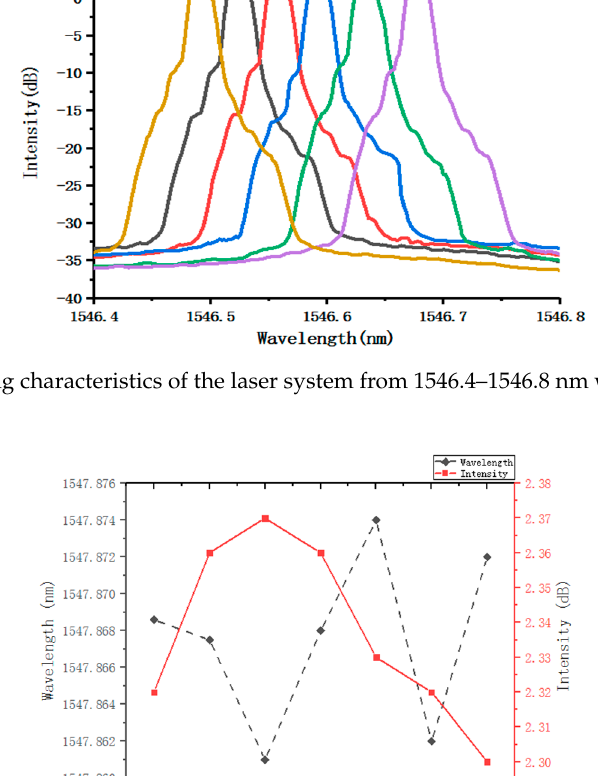
6 of 8 Figure 5. Typical laser signal with the wavelength centered at 1546.733 nm. Different holograms are loaded onto the DMD chip, each hologram corresponds to a different selected wavelength. Each selected wavelength is amplified by EDFA to achieve lasing. Figure 6 is the measured outputs of the echelle-grating-based fiber laser tuning from 1542 to 1558 nm by remotely uploading the 8 × 768 pixel-holograms at different positions along the DMD active window when the threshold pumping power is 28 mW. It demonstrates an excellent tuning capability. Notice that the range of the actual tuning wavelength is a little wider than 16 nm. The wavelength outside the tuning range requires a higher threshold power to lasing due to the off-axis angle and the influence of stray light. Figure. 6. Coarse tuning characteristics of fiber laser in the range 1542–1558 nm. Figure 7 is the fine tuning characteristics of laser outputs with the fine tuning accuracy 0.036 nm. We modulate the selected wavelength each time by moving 2-pixels on the hologram. The tuning accuracy corresponding to each pixel is related to the number of DMD pixels covered by the ASE spectrum on the surface of the DMD. Note that the tuning accuracy can be further improved